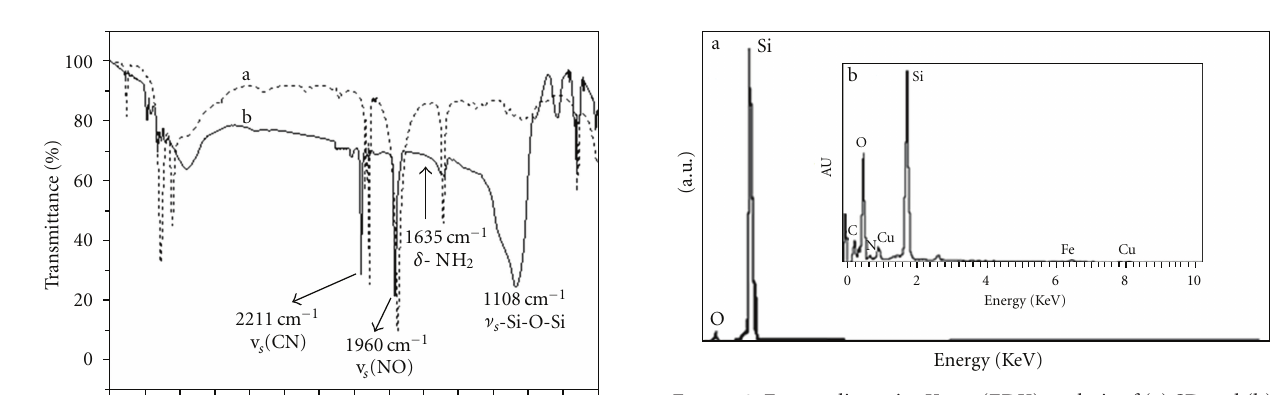
Figure 3: Energy dispersive X-ray (EDX) analysis of (a) SD and (b)